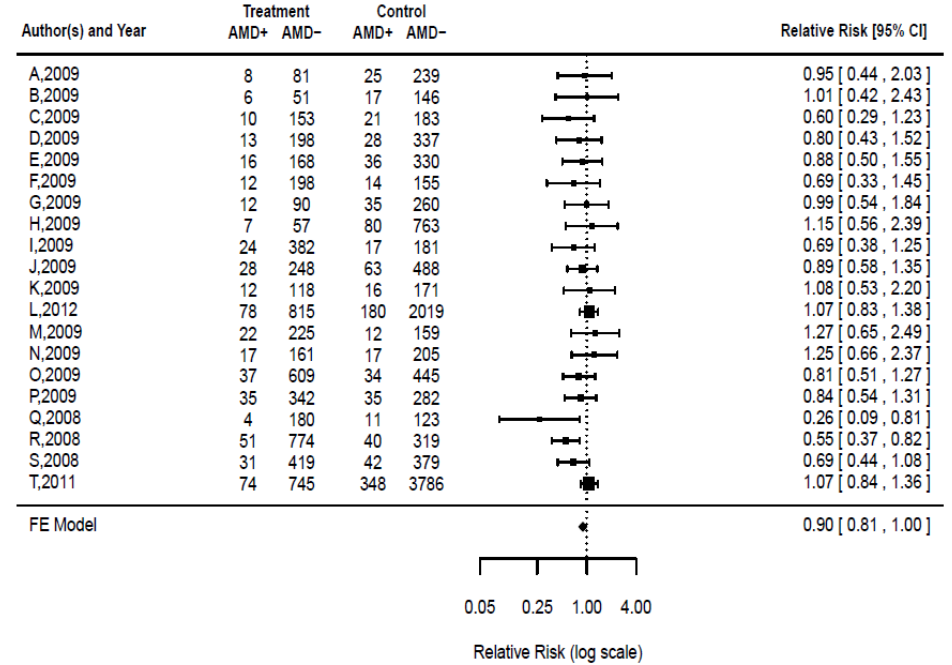
Figure 1. Forest plot for fixed effects